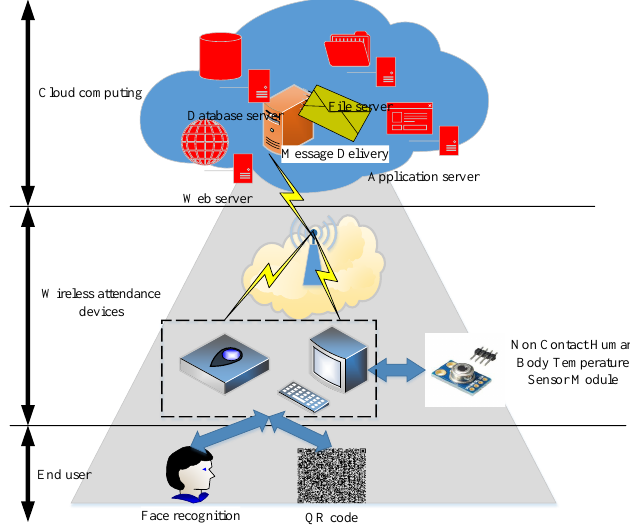
Figure 2. Architecture of IoT-based intelligent